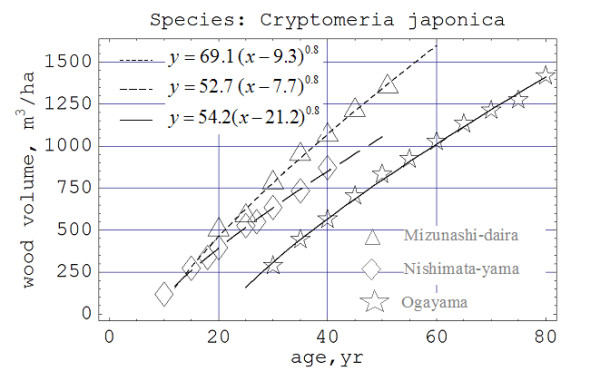
The model fits superimposed on the data from the permanent monitoring plots of the Japanese Forest Resources Monitoring System. (For restoring the normal pattern of forest growth the total amount of wood cut by a given age was added to reported wood stock at this age.)